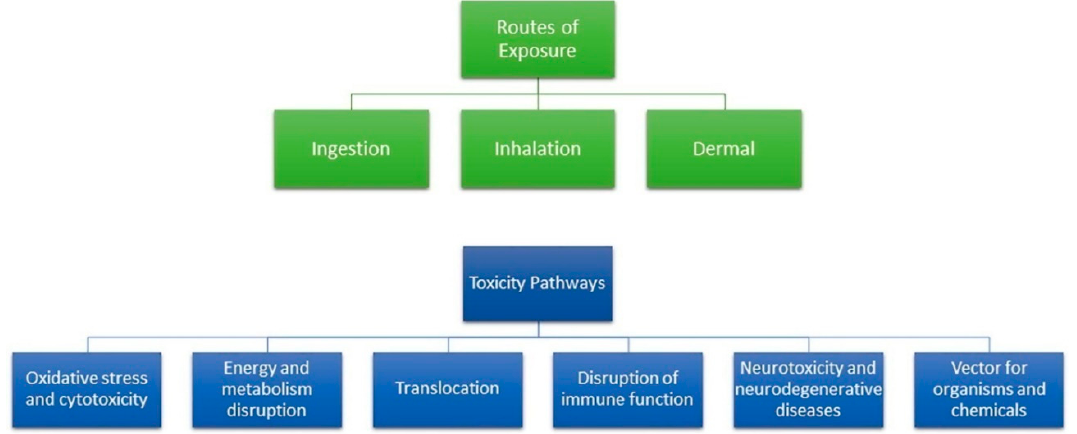
Figure 11. Three exposure routes and various toxicity pathways of MPs in the human body [87]. Table 3. The toxicological, pathological, and behavioral changes in mice and rats on MP / NP treatment. (We modified a summary table referred from